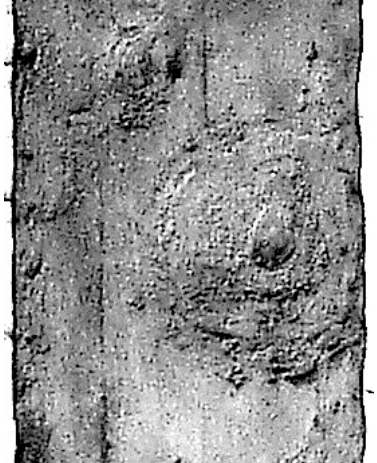
Figure 1. Near-circular cathodic area of some 30–35 mm diameter around a pit of about 8 mm diameter on part of a mild steel strip after one year of continuous exposure in unpolluted natural seawater. (Scale: horizontal width = 50 mm).